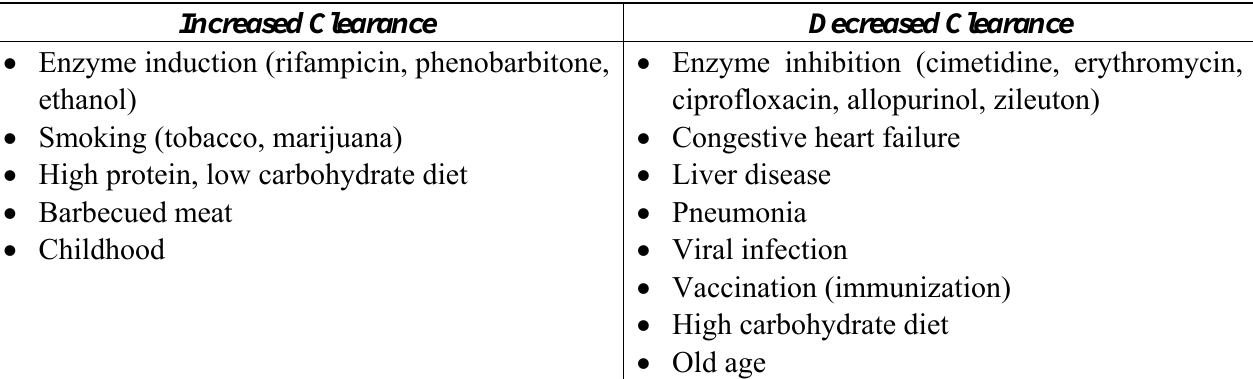
Table 2. Factors affecting clearance of